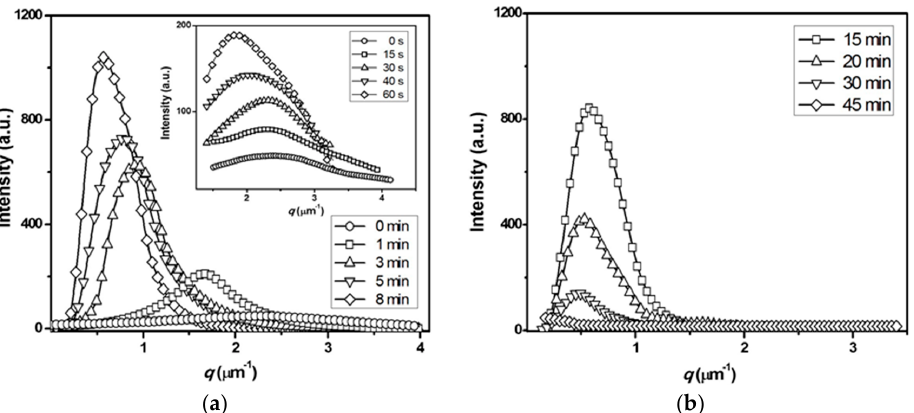
Figure 1. Change in the one-dimensional V v light scattering profiles of the PTT/phenoxy resin blend